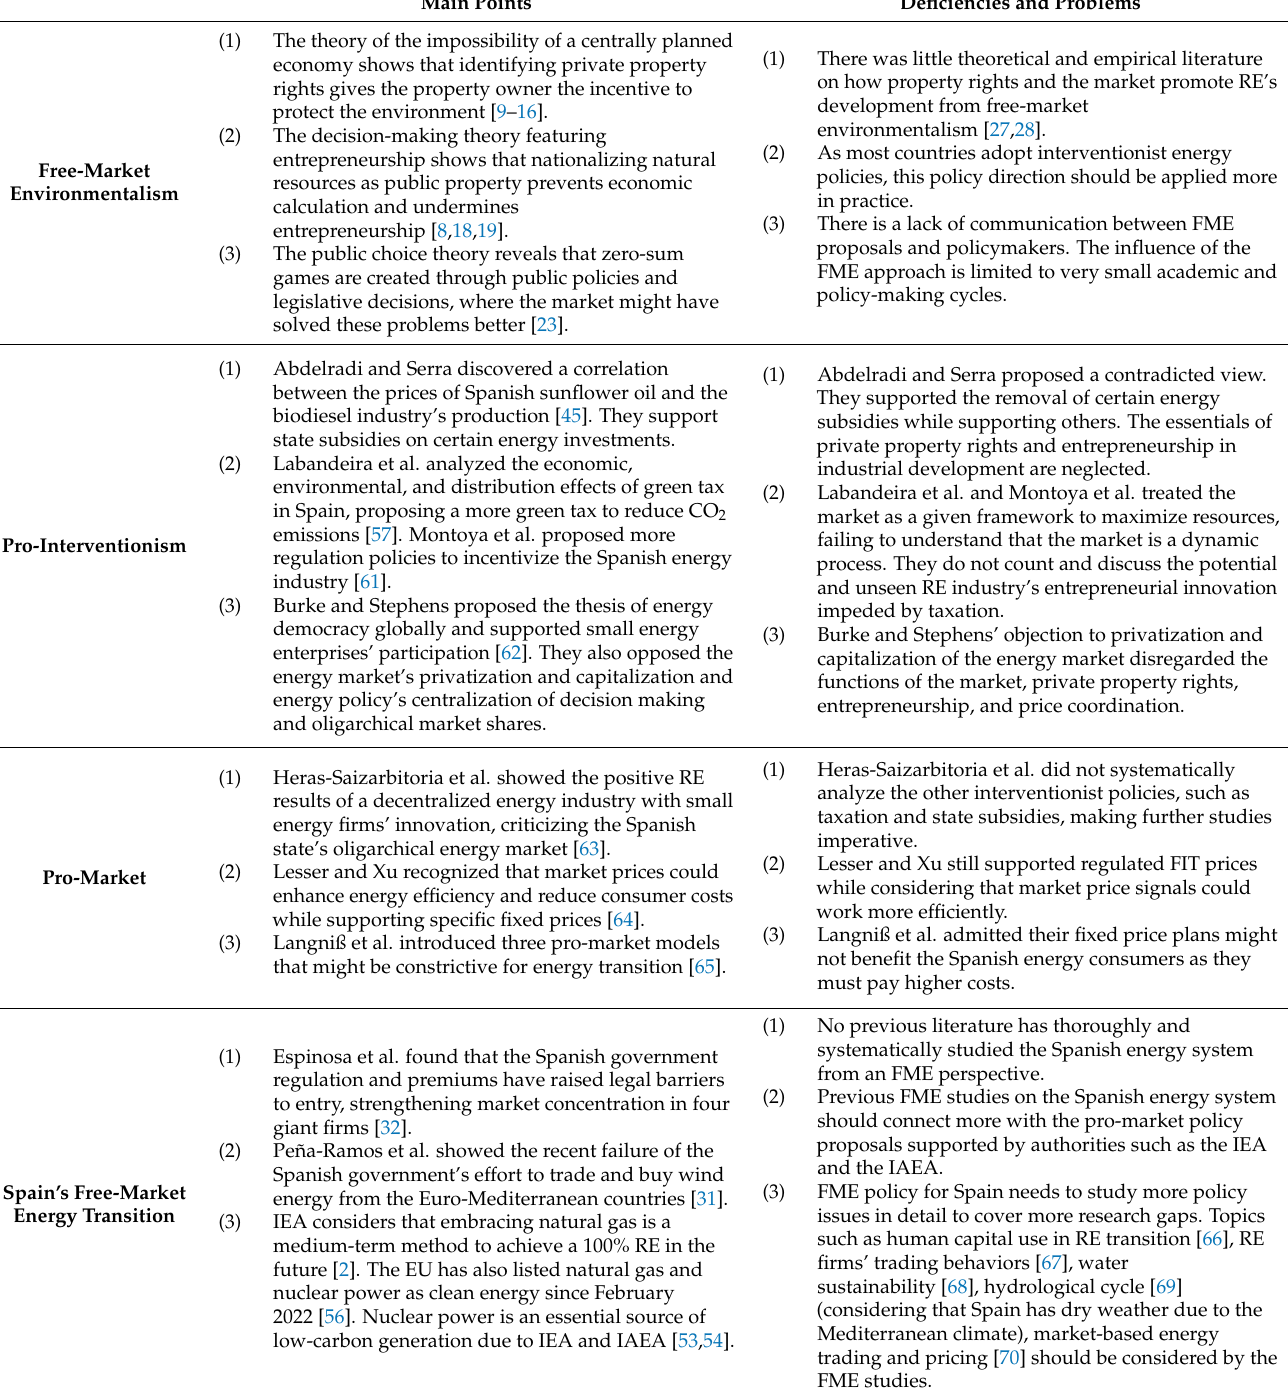
Table 1. Main points and deficiencies of different policy approach to Spain’s energy